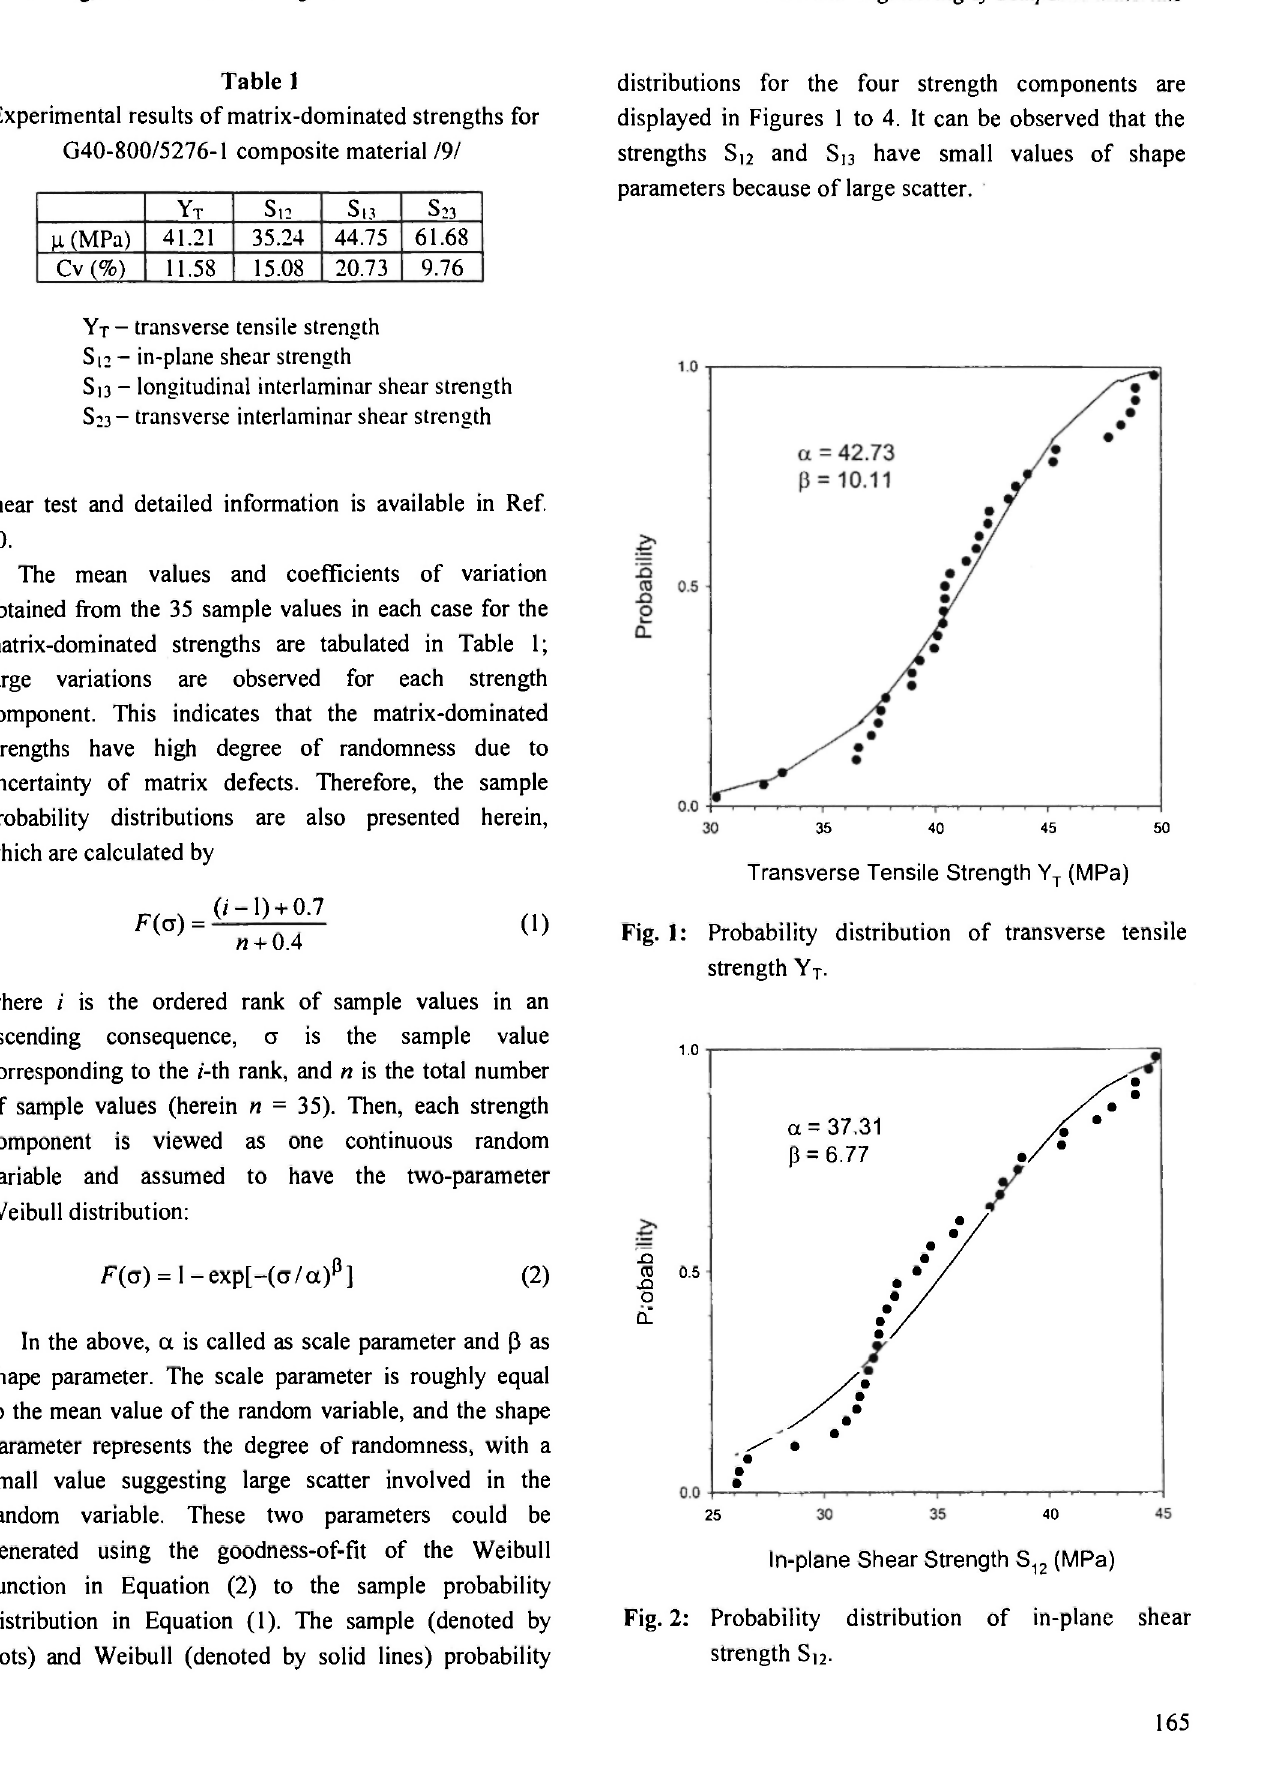
Fig. 1: Probability distribution of transverse tensile strength Y T .